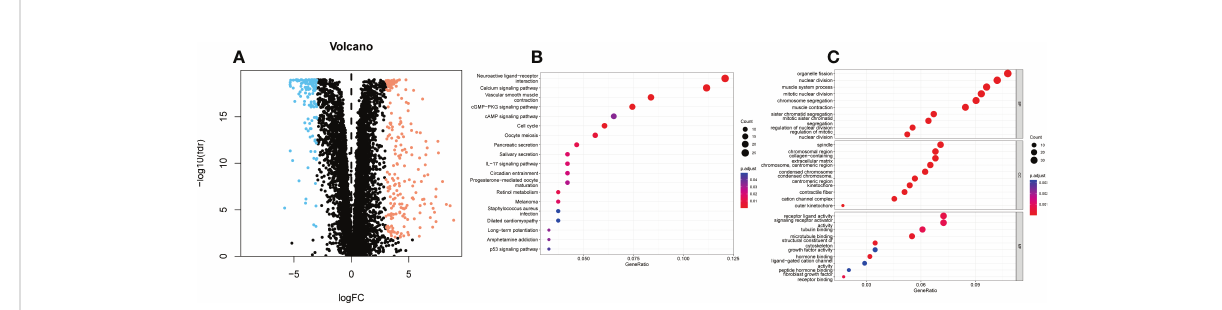
FIGURE 1 KEGG and GO analyses of endoplasmic reticulum stress related DEGs in UCEC and adjacent tissues. (A) Volcano plot of 8763 endoplasmic reticulum stress related genes in UCEC. Blue dots represent downregulated genes and yellow dots represent up-regulated genes. (B) KEGG analysis of endoplasmic reticulum stress -related DEGs. (C) GO analysis of endoplasmic reticulum stress related DEGs. KEGG, Kyoto Encyclopedia of Genes and Genomes; GO, Gene Ontology; DEGs, differentially expressed genes; fdr, false discovery rate; FC, fold change; BP, biological process; CC, cellular components; MF, molecular